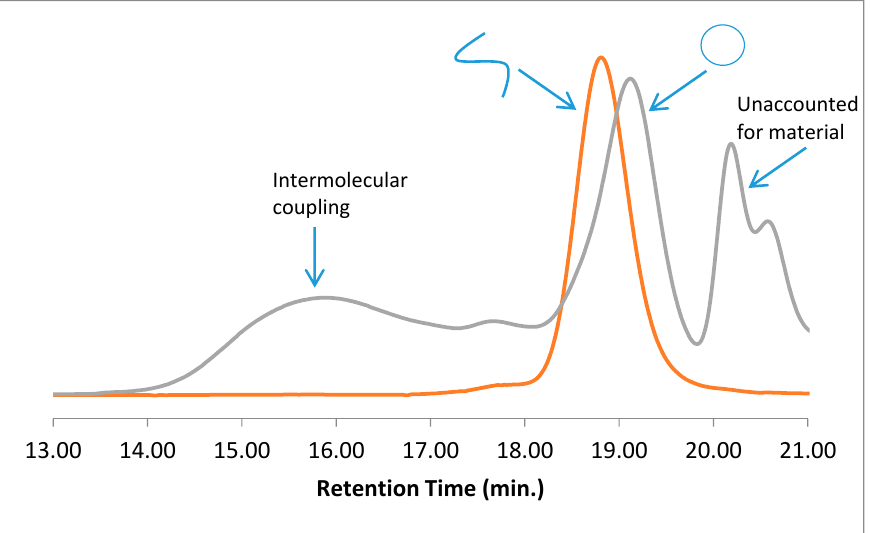
Figure 1. GPC traces of N 3 –PS–N 3 precursor (orange) and unpurified product of intramolecular “click” cyclization reaction (gray). “Click” reaction was conducted at 60 °C and [N 3 –PS–N 3 ] of 0.1 mM. Precursor characteristics: M n : 3900 Da, M p : 4150 Da, Đ : 1.11. Cyclic product characteristics: M p : 3300 Da, <G> = 0.80.